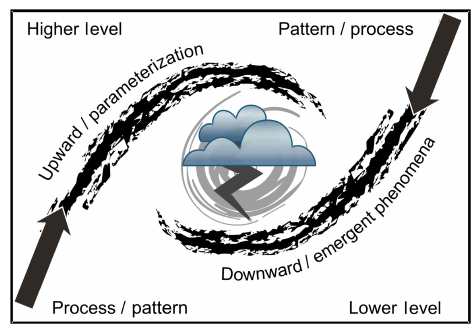
Figure 4. Reconciliation of downward and upward approaches – break from a reliance on parameterization of lower-level features to discovery and explanation of emergent phenomena at the higher level. Taken from Sivapalan